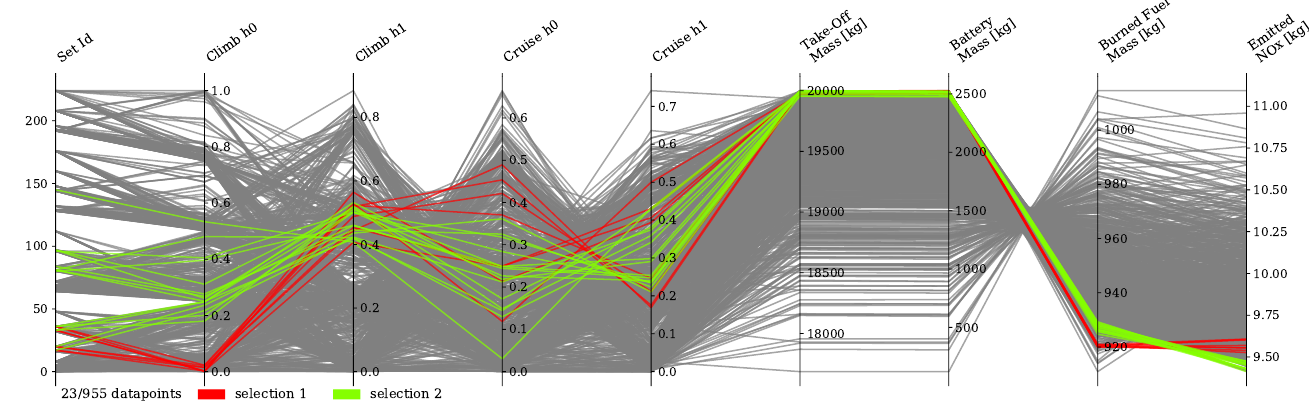
Figure 16. Parallel coordinates visualisation of Experiment 6.